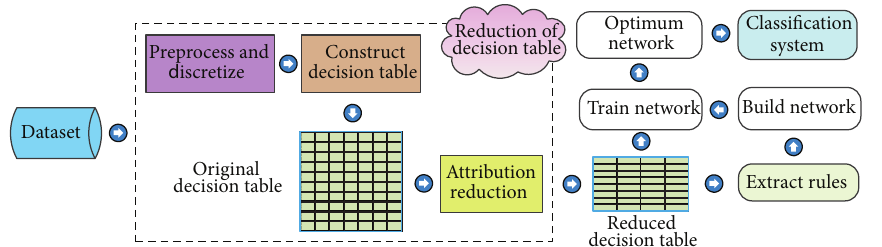
Figure 2: The system construction